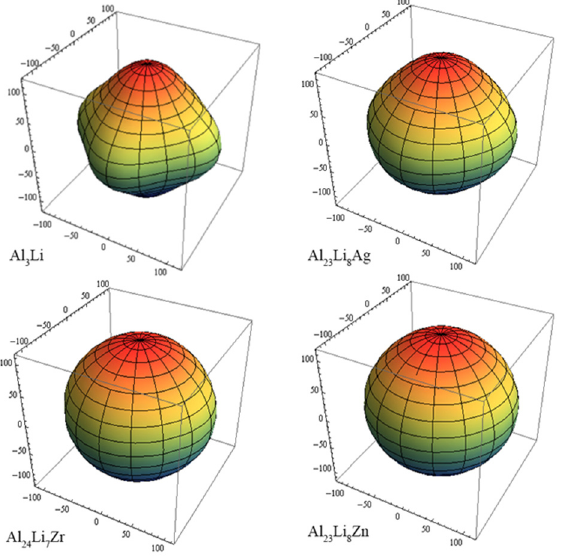
Figure 2. The 3D Young’s modulus E visualization surfaces of pure and doped Al 3 Li phases.